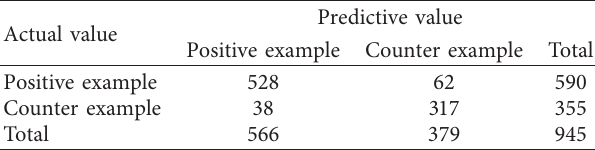
Table 3: Confusion matrix of NB classification results.